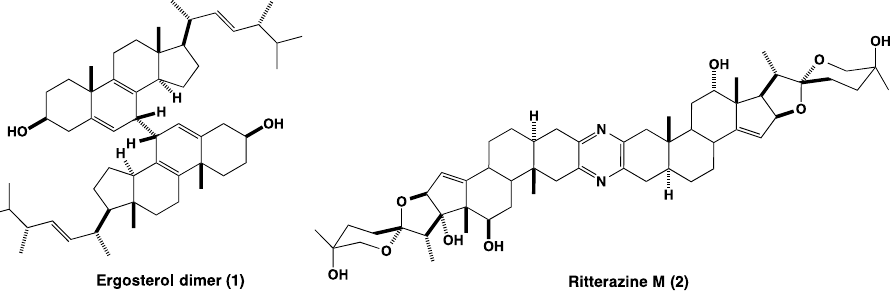
Figure 1. Photochemically formed dimer from ergosterol ( 1 ) and naturally occurring dimer Ritterazine M ( 2 ).